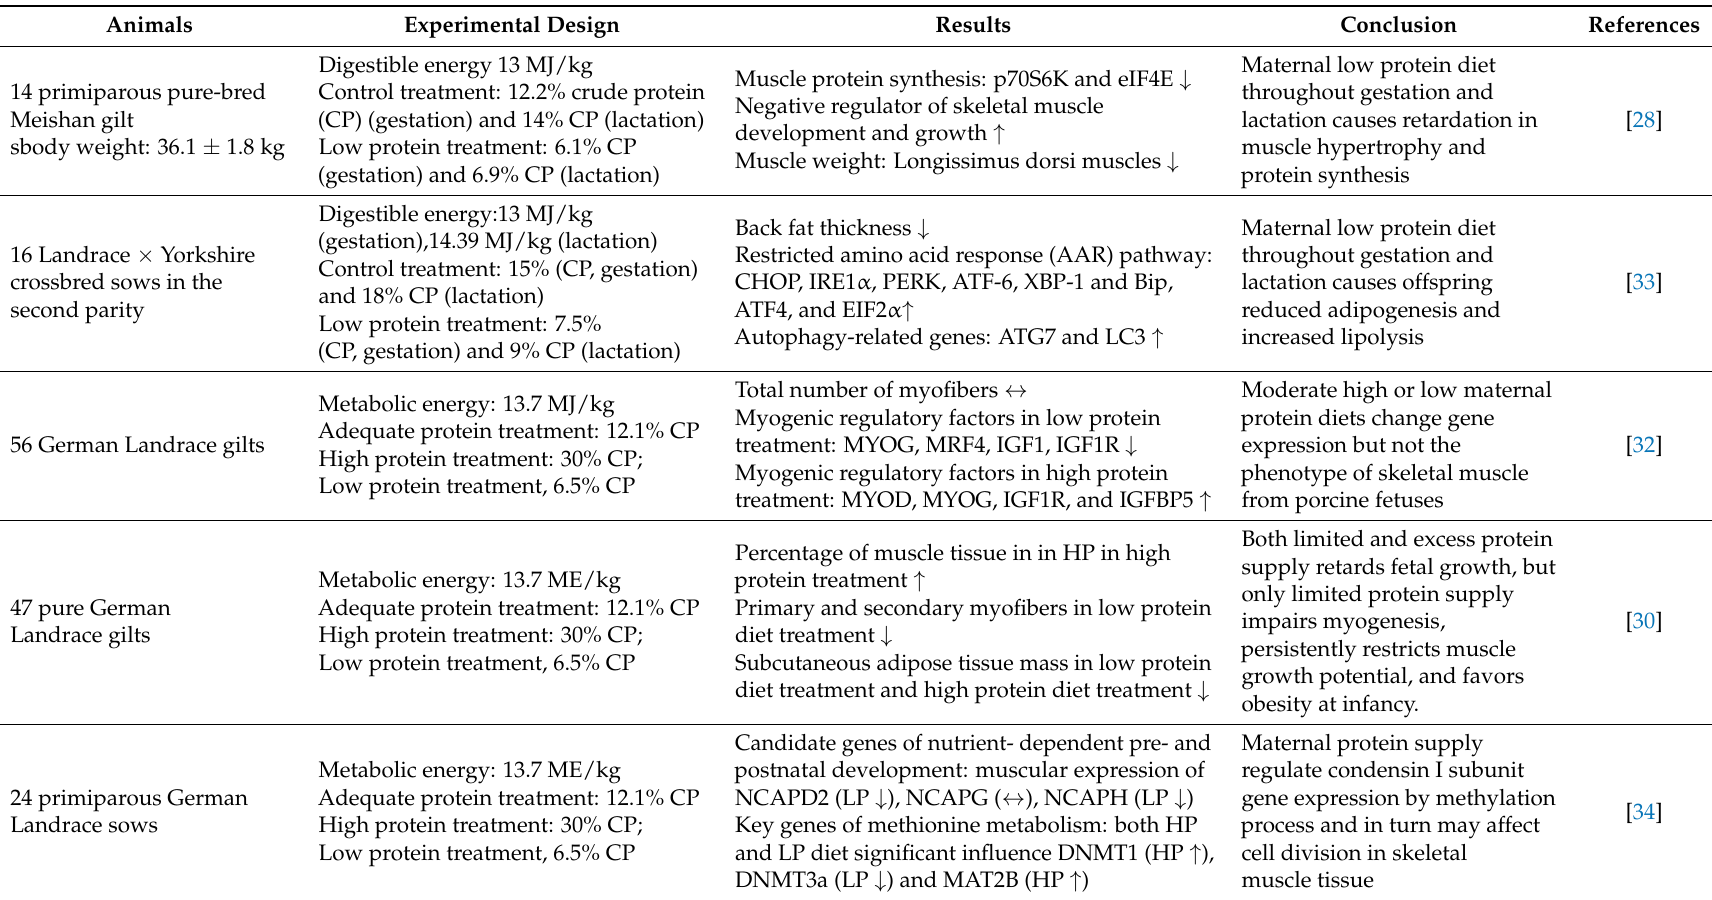
Table 1. Effect of different maternal protein levels on early fetal muscle development. Upward-pointing arrow: “increase”; downward-pointing arrow: “decrease”; horizontal arrow: “no